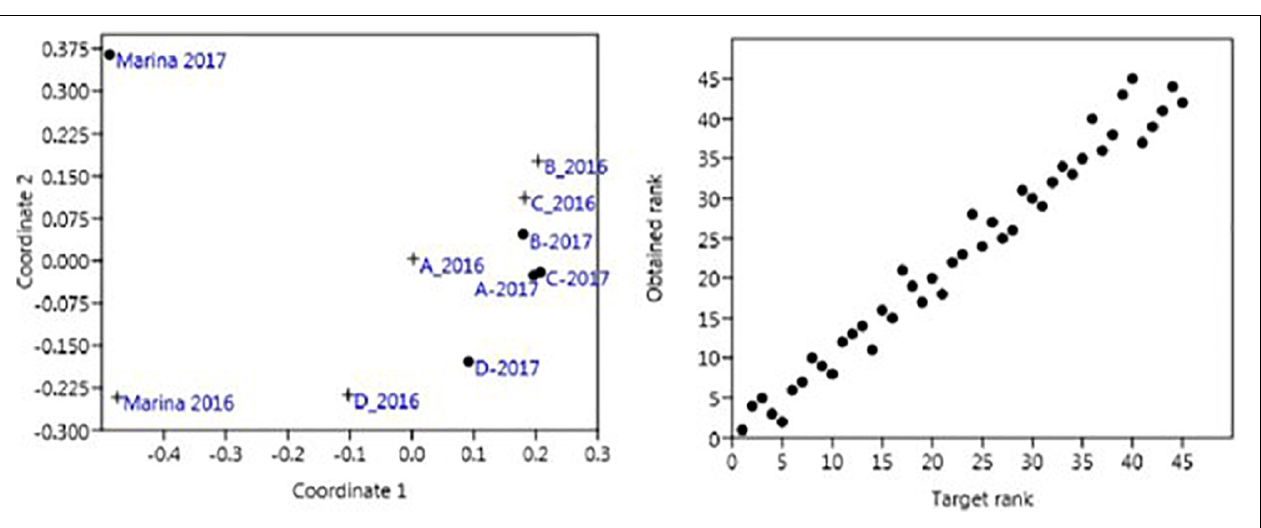
FIGURE 5 | Two-dimension non-metric multidimensional scaling (nmMDS) plot of the areas under study in the Port of Gijon, Bay of Biscay, Spain in 2016 and 2017 and its Shepard plot. Crosses represent samples collected in 2016 and dots represent samples from 2017. The name of the area is given (A–D and Marina). Stress value is